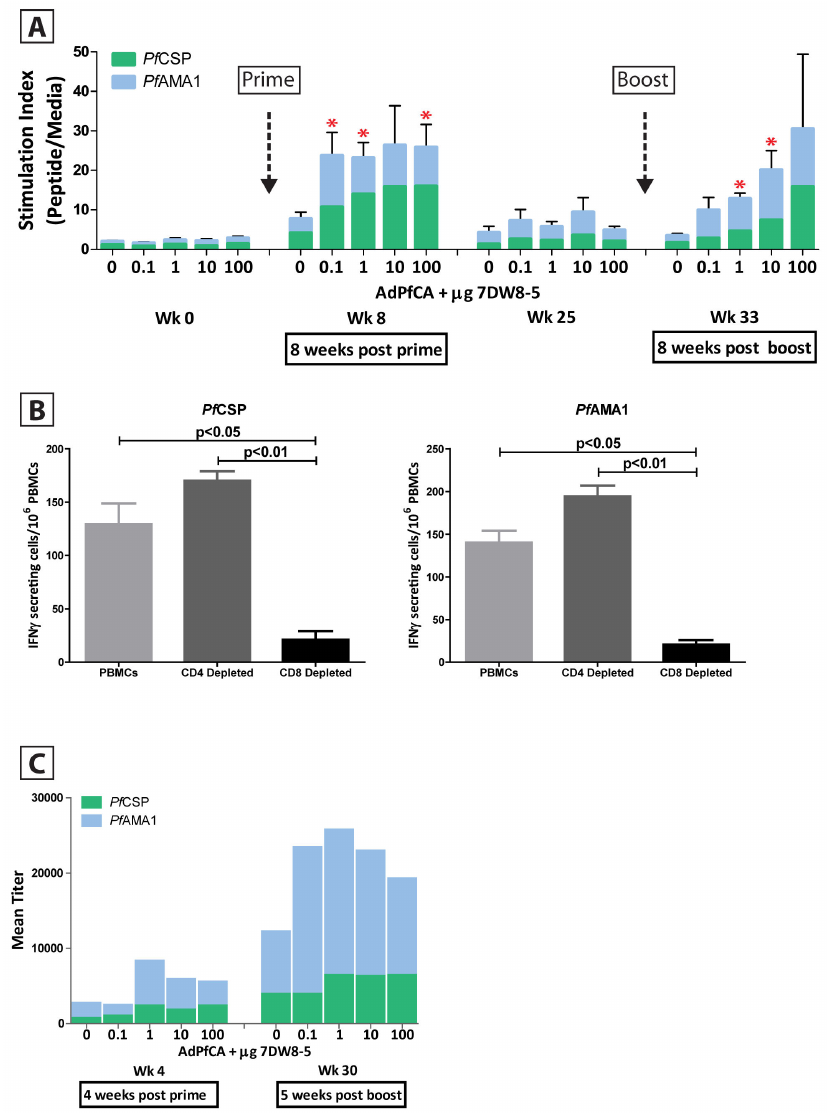
Figure 1. Adjuvant effect of 7DW8-5 on AdPfCA in rhesus macaques. (A) Cellular immunogenicity upon 7DW8-5 and AdPfCA co-administration in vivo . Five animals per group were vaccinated with AdPfCA alone (control) or in combination with one of four ascending doses of 7DW8-5. PBMCs were isolated before prime and boost and at eight weeks post prime and post boost, stimulated with Pf CSP- or Pf AMA1-specific peptides, and the number of IFN-γ-secreting cells was measured by ELISpot assay. Stimulation index was calculated as the number of spots detected in the respective peptide stimulated well divided by the number of spots in the media only well, and the bars displayed are the mean of 5 animals per dose group. All samples were run in duplicate. Asterisks represent statistical significance (p < 0.05) for the summation of Pf CSP- and Pf AMA1 T-cell responses for each respective dose group as compared to the control dose group (AdPfCA + 0 μg 7DW8-5), and error bars represent the standard error for the five animals per group. (B) Enhancement of malaria-specific CD8+ T-cell responses by 7DW8-5. PBMCs from four macaques that received AdPfCA + 100 µg 7DW8-5 were isolated at eight weeks post boost, depleted of CD4+ or CD8+ T cells, stimulated with Pf CSP-or Pf AMA1-specific peptides, and the relative number of IFN-γ secreting cells were determined by ELISpot assay. All samples were run in duplicate and subtracted for background levels measured in cells stimulated with culture medium containing 0.01% DMSO (negative control). Error bars represent the standard error between duplicated wells. Representative data from one animal are shown. (C) Humoral immunogenicity upon in vivo co-administration of 7DW8-5 and AdPfCA. Animals were vaccinated with AdPfCA alone or in combination with 7DW8-5 as described above. Sera were isolated at four weeks post prime and three weeks post boost and measured for levels of PfCSP- and PfAMA1-directed antibodies. Values presented are a mean of 5 animals per group at each respective time point. All samples were run in duplicate. doi: 10.1371/journal.pone.0078407.g001 PLOS ONE |